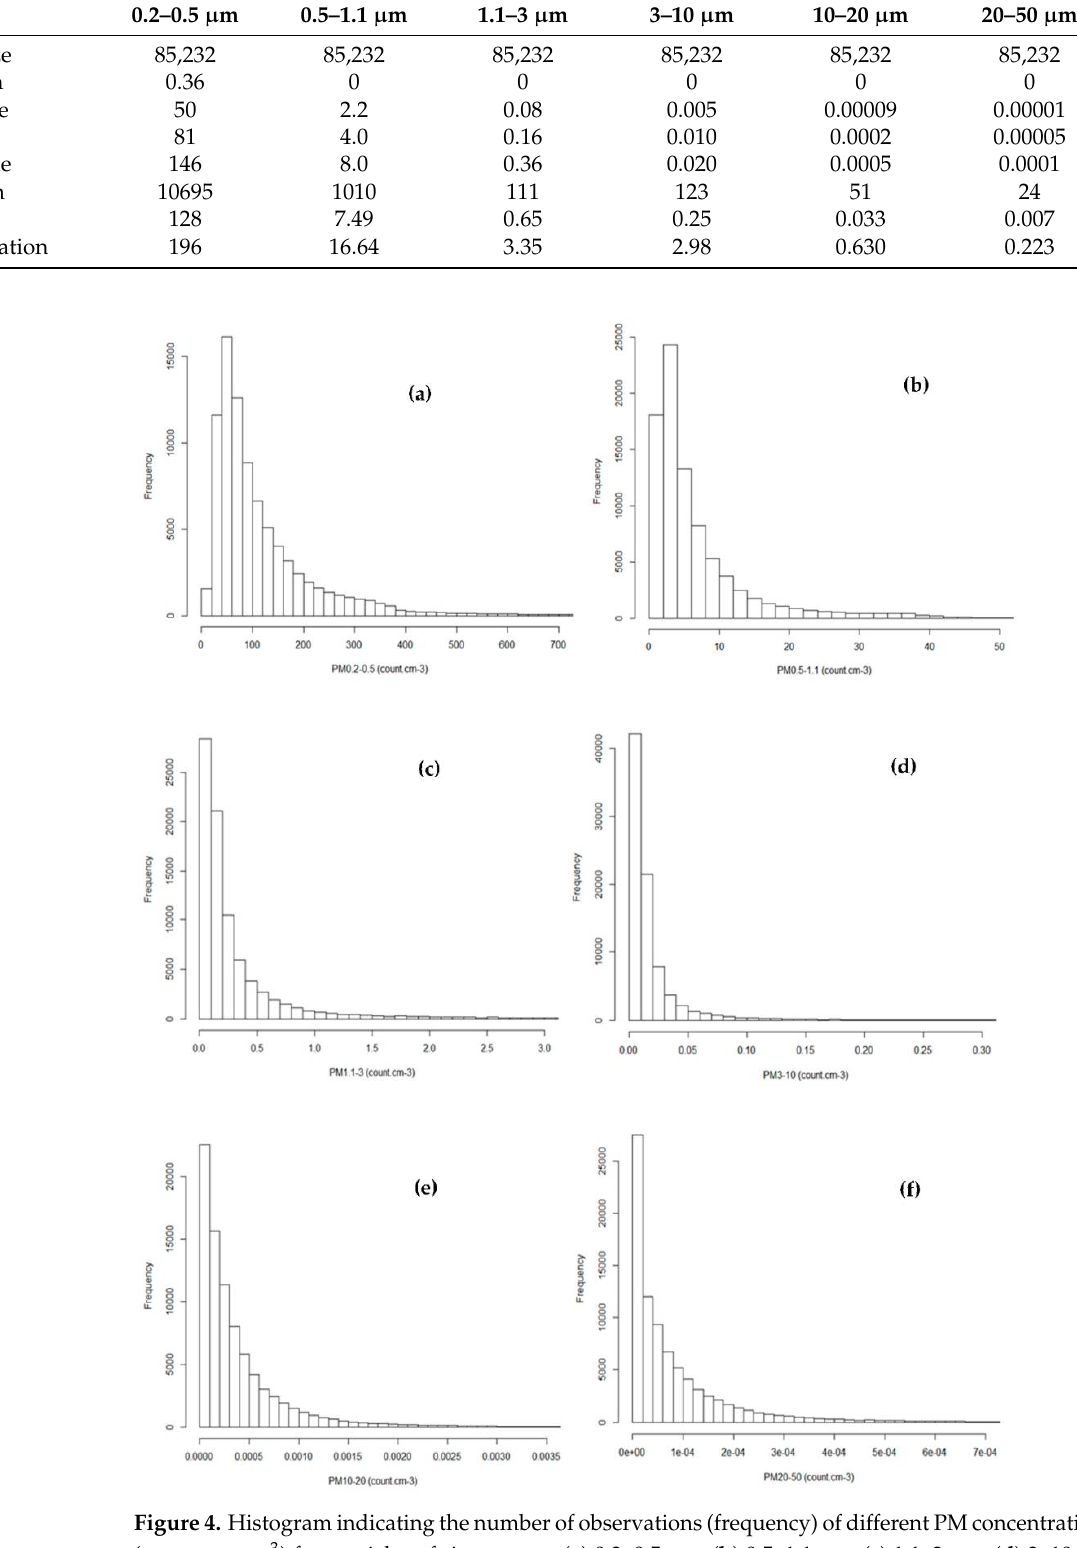
Table 2. Descriptive statistics of the PM concentrations in the three locations between 2013 and 2019.